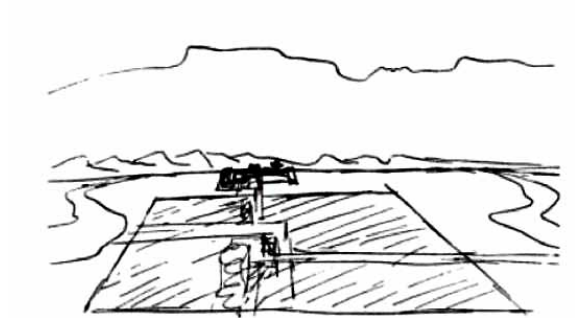
fig. 13. le Corbusier sketch of urban ideas of Chandigarh with Capitol as its “head” – observe the deformity of the urban planning and order (Von Moos 2007)